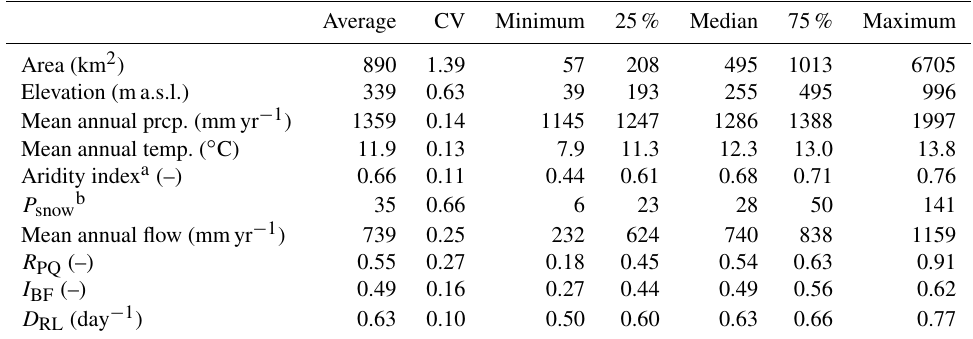
Table 1. Summary of hydrological features of the study catchments.